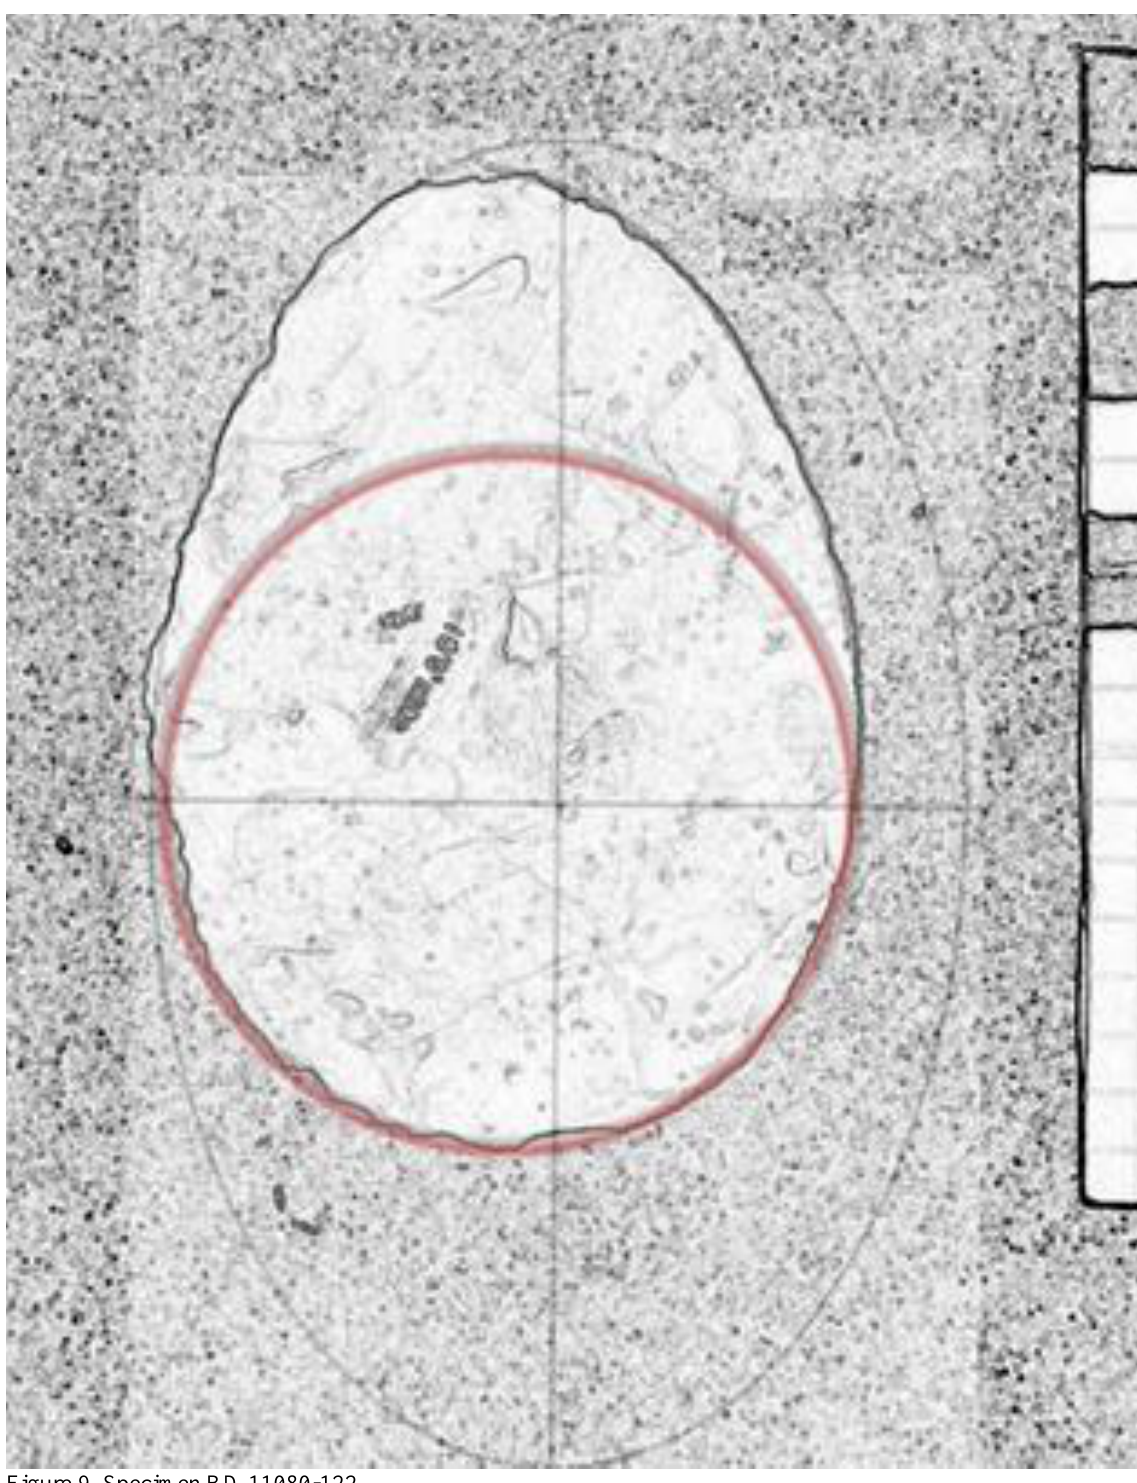
Figure 9. Specimen BD